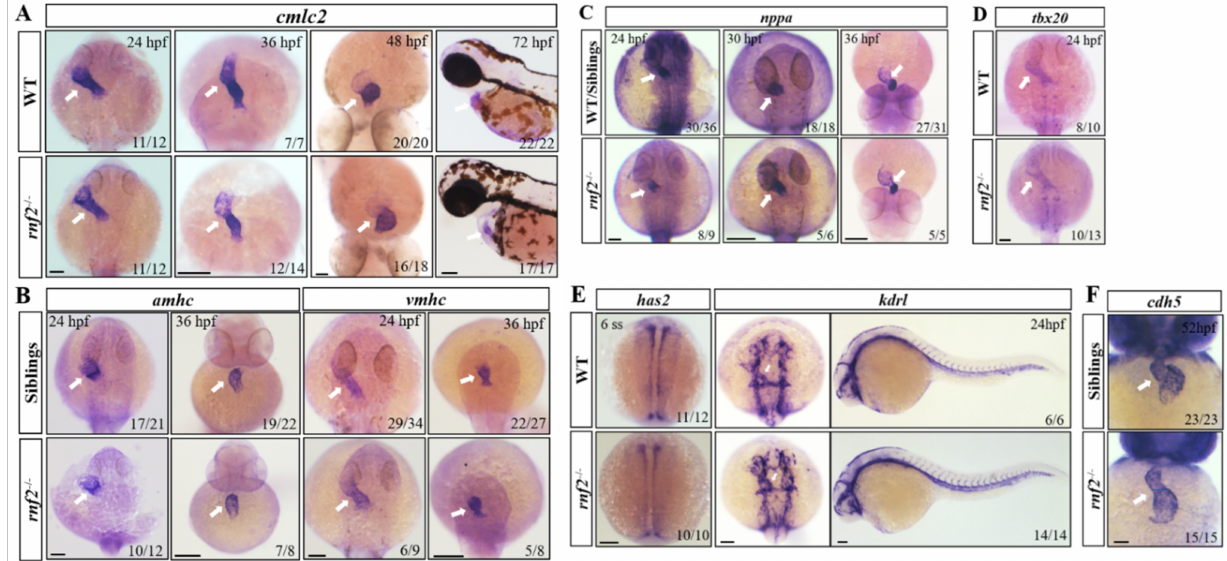
Figure 4. Expression of cardiomyocyte markers examined by in situ hybridization. ( A ) cmlc2 at different developmental stages; ( B ) Atrial ( amhc ) and ventricle ( vmhc ) cardiomyocyte markers at 24 hpf and 36 hpf; ( C ) Growth factor nppa at 24 hpf, 30 hpf, and 36 hpf; ( D ) tbx20 at 24 hpf; ( E ) Expression of endocardial precursor marker gene has2 and endothelial marker gene kdrl in the heart and blood vessels, white arrows indicate the heart tube; (F ) Expression of endothelial marker gene cdh5 in the heart. The expression of genes in the heart is indicated by white arrows. Scale bar: 0.2